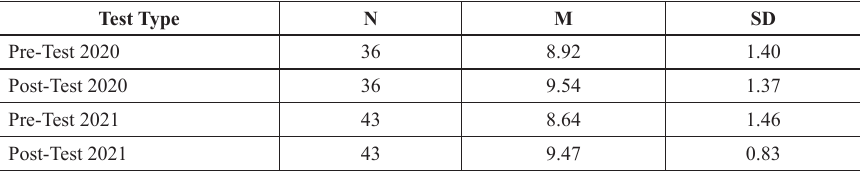
Table 5. “Particle Accelerators and Detectors” lab pre and post test results